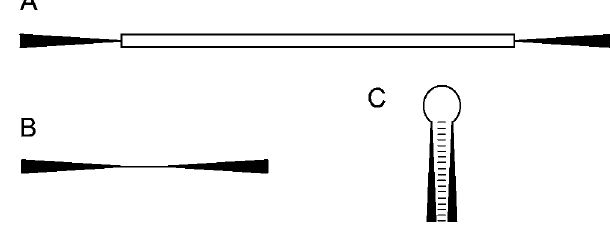
Figure 2. Schematic illustrating the relationship between Hsmar DNA-type TEs (A), Made1 MITEs (B) and hairpins (C) of the kind recognized by the miRNA enzymatic processing machinery. A) A full length DNA-type element with terminal inverted repeats (TIRs) flanking an open reading frame (ORF) is shown. B) Non-autonomous MITE derivative of a full length DNA-type element, containing TIRs but no internal ORF. C) Predicted hairpin structure that would be formed by base-pair interactions of the MITE